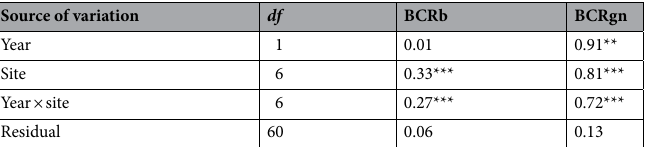
Table 1. Mean squares from the three-way analysis of variance for the competitive ratio of susceptible (S) and herbicide-resistant blackgrass (R) calculated for the relative plant biomass (BCRb) and relative grain